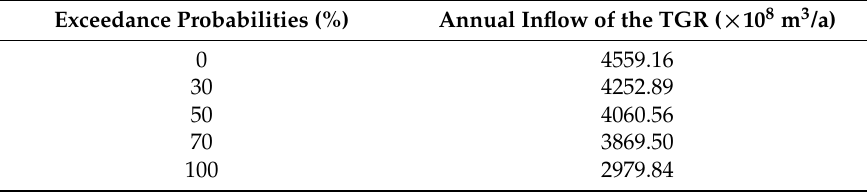
Table 2. The annual inflow values of the TGR in different exceedance